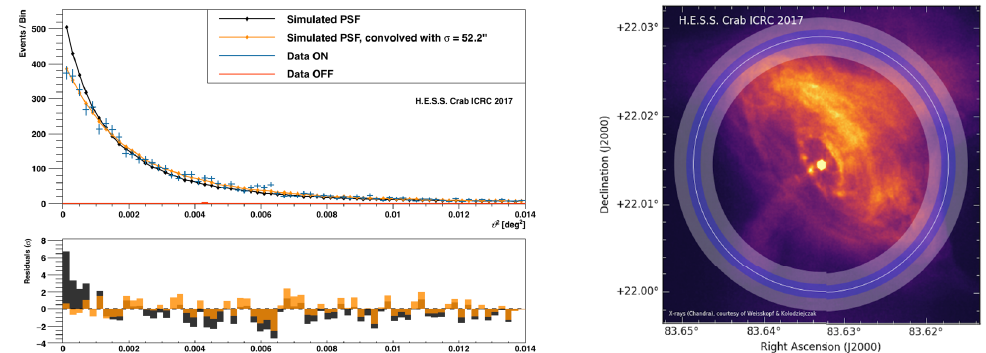
Figure 2. Left: θ 2 histogram of γ -like events from the Crab nebula (ON) and control regions (OFF). Simulated PSF and the PSF convoluted with the best-fit Gaussian are shown as well. Right: Chandra X-ray image of the Crab nebula. The H.E.S.S. extension is shown as solid white circle overlaid on top of shaded annulus indicating the statistical and systematic uncertainties of our measurement. From